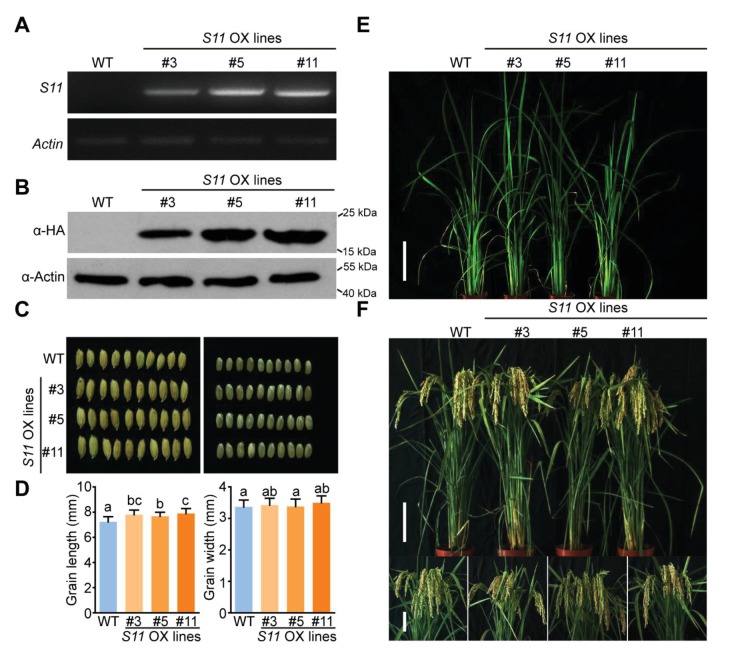
Phenotype and identification of S11-overexpressing lines.(A) Expression levels of S11 driven by the Ubiquitin promoter in transgenic rice lines (#3, #5, and #11). Actin was used as an internal control. (B) Western blot analysis of Pns11 protein expression level in transgenic lines. Actin was probed and served as a loading control. (C) Comparison of seed size with (left panel) or without the hull (right panel) from WT and three S11-overexpressing lines. (D) Statistical analysis of the seed length and width of well-filled grains. Each value is average of 8 plants and each plant has 100 grains. Bars indicate SD. Tukey’s honestly significant difference post hoc test was performed for multiple comparisons, different letters indicate significant difference between the compared pairs (p<0.05). (E) Phenotypic comparison of field-grown plants at vegetative growth status. Bar = 10 cm. (F) Phenotypic comparison of field-grown plants at grain-filling period. Bar = 15 cm (upper panel) and 10 cm (lower panel).